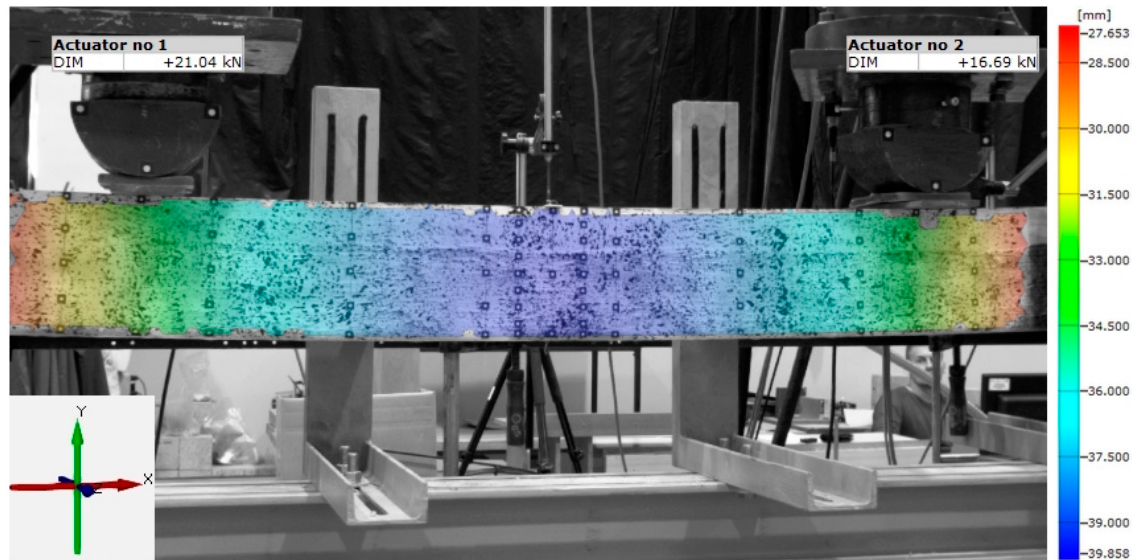
Figure 1. ARAMIS system-map of vertical displacements for beam B1.